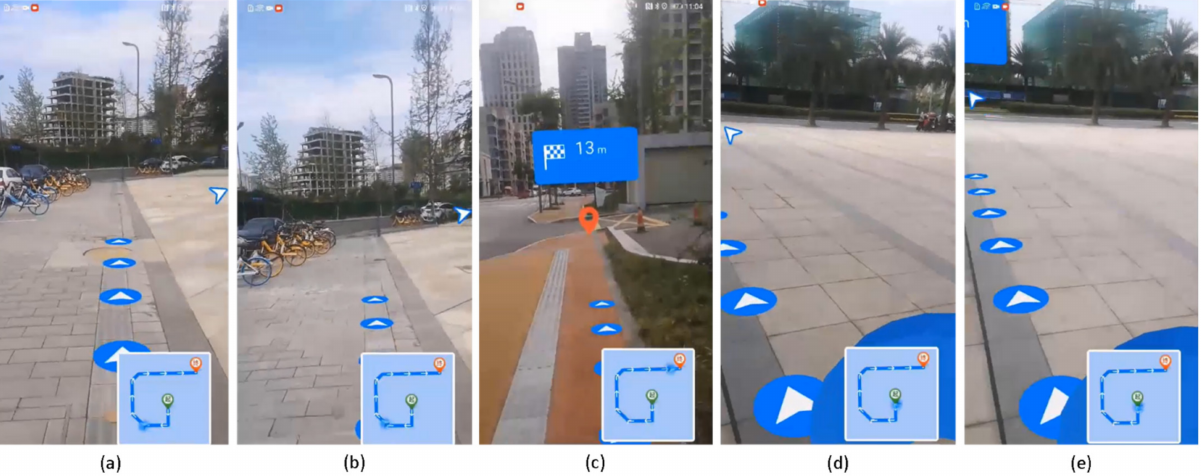
Figure 4. Arbitrary rotation of quaternion-based spatially oriented data: ( a ) Arrows that lead to the right; ( b ) Continue to the arrow that points to the right after following the guide; ( c ) Space objects (arrows) that are based on quaternion operations vanish and are replaced with destinations; ( d ) Arrow pointing to the left; ( e ) Continue following the arrow to the left after following the guide.